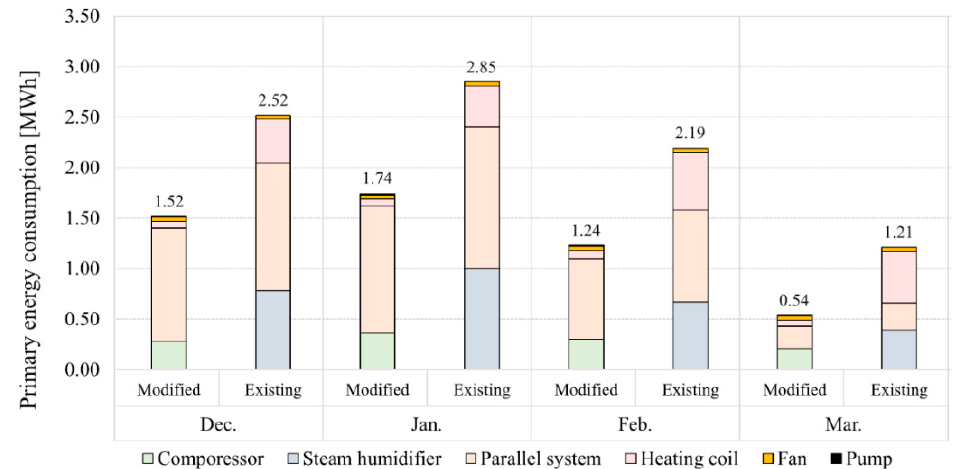
Figure 15. Monthly primary energy consumption of each system.